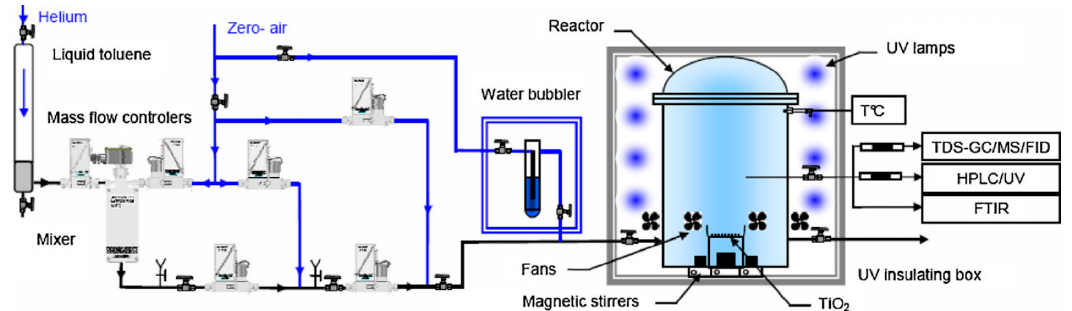
Figure 8. Experimental air treatment setup proposed by Debono et al. (2011). Reprinted from References [77,78], Copyright (2011), with permission from Elsevier.